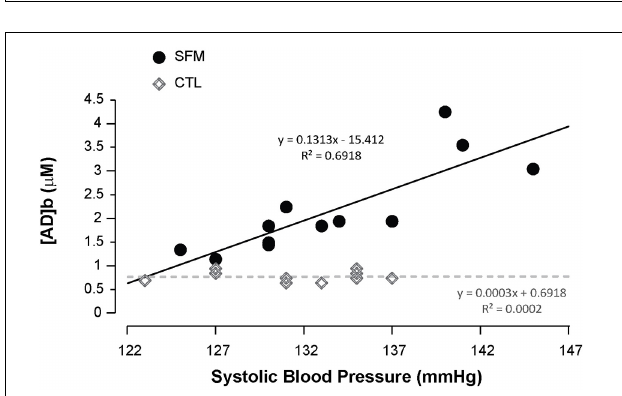
FIGURE 5 | Correlations between the SpO 2 values recording during the apnea and the blood adenosine concentration in spearfishermen (SFM) and control (CTL)